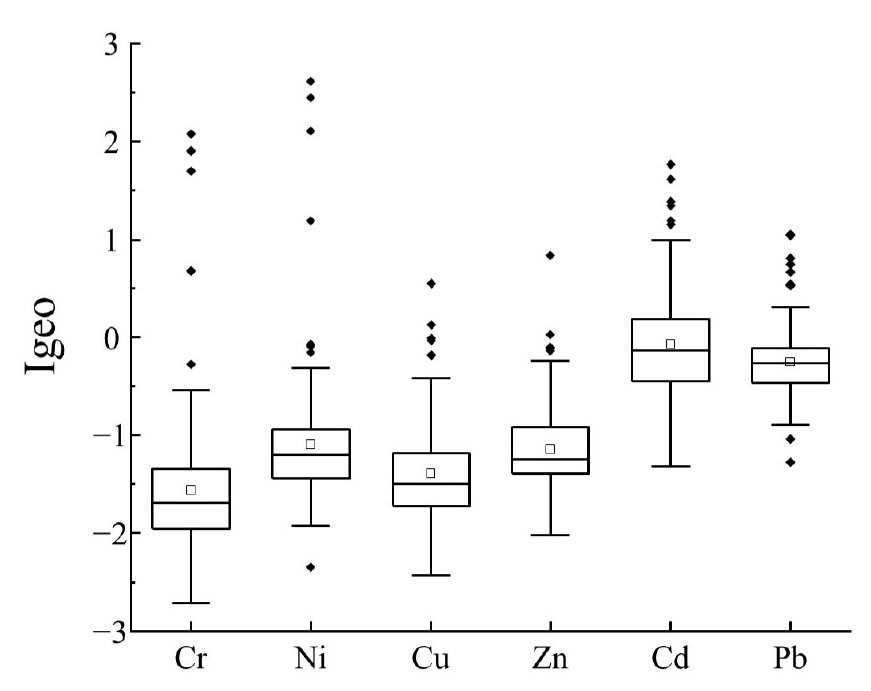
Figure 4. Boxplots of the geo-accumulation index ( I geo ) for heavy metals in soil